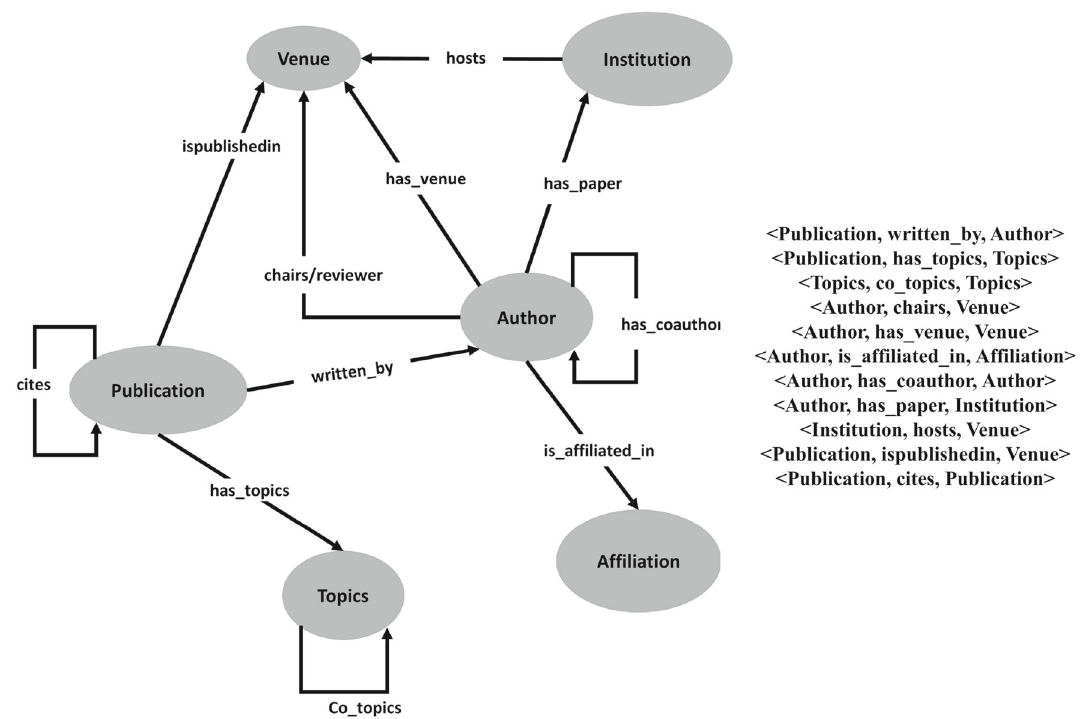
Fig. 2 Pictorial view of example of entities/relationships and triples in scholarly knowledge graph